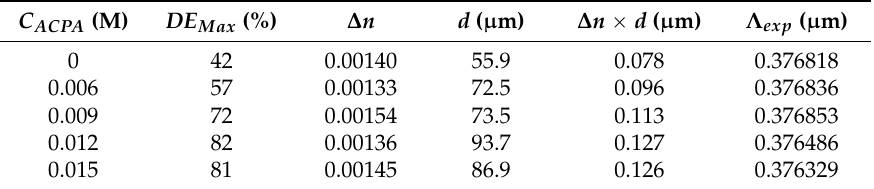
Table 2. Parameters obtained from the fitting of the gratings in Figure